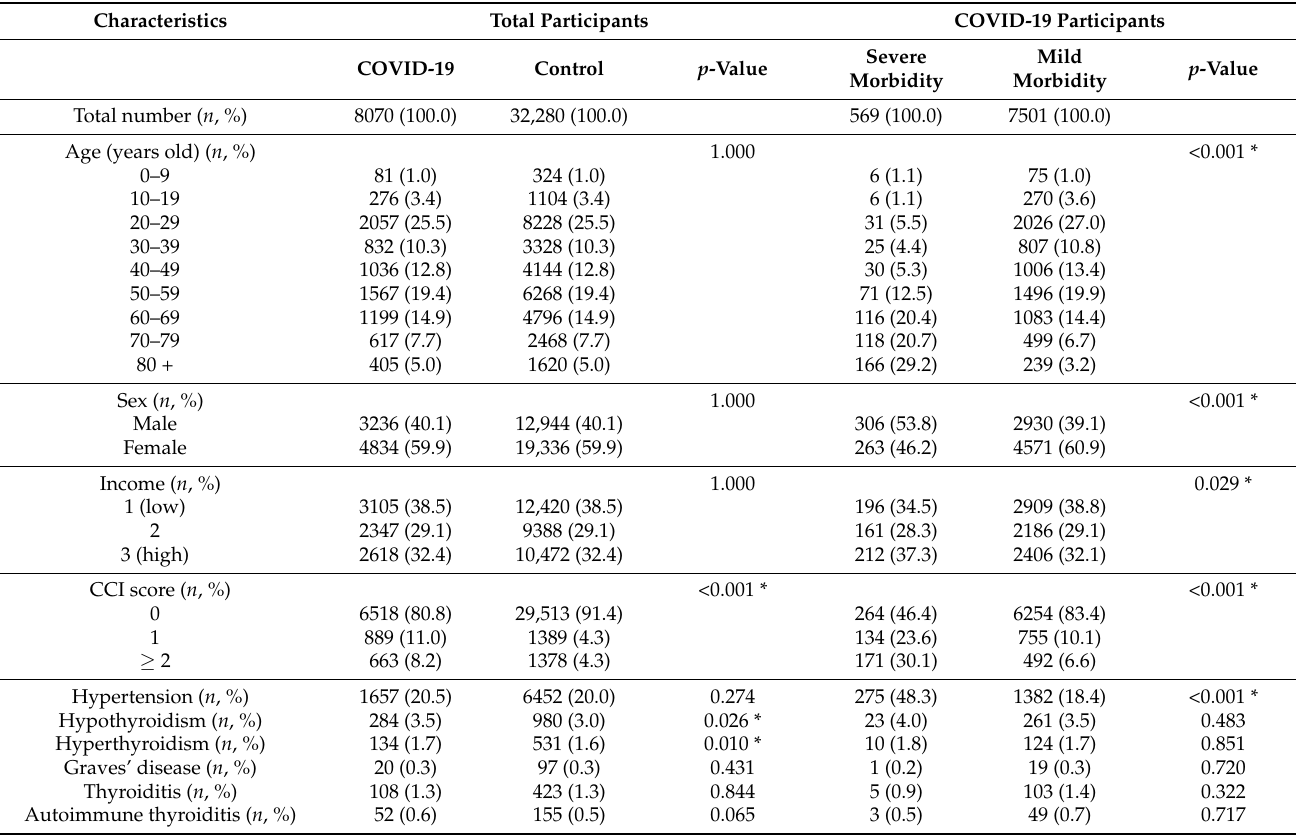
Table 1. General Characteristics of Participants.